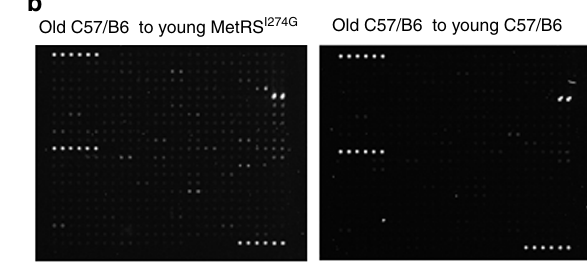
(Supplementary Table 2). Three independent proteomics array